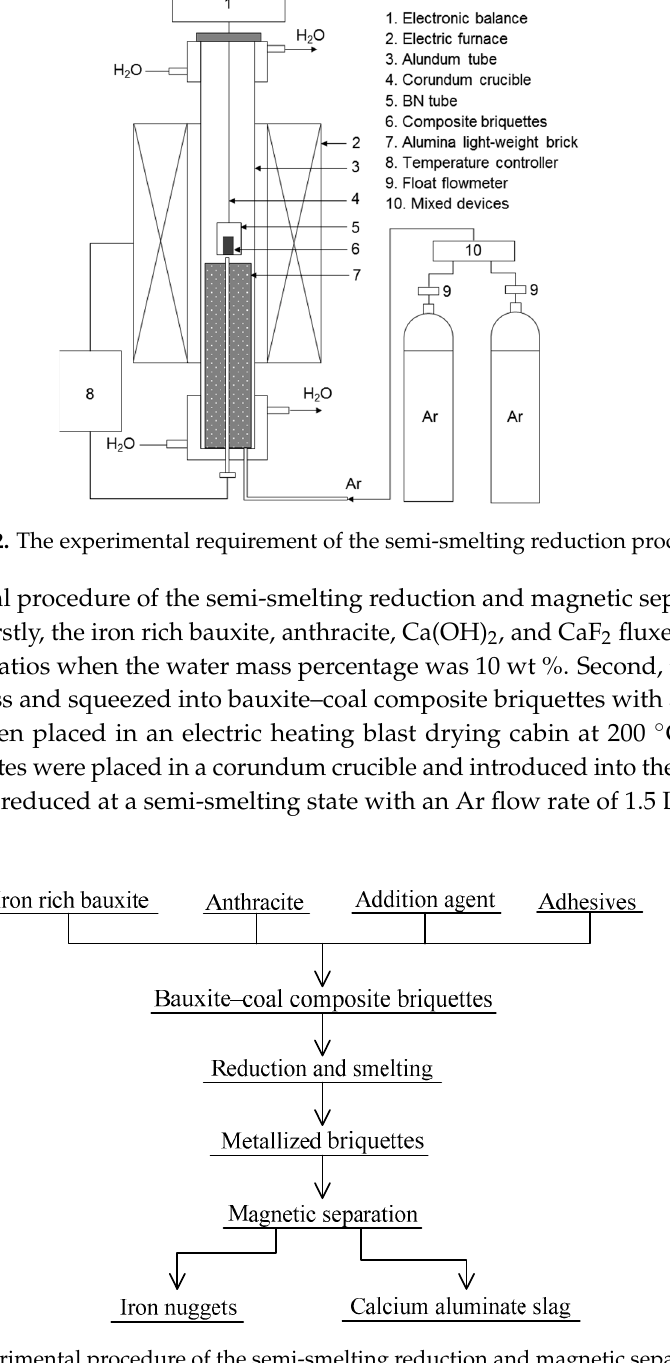
Figure 2. The experimental requirement of the semi-smelting reduction process.